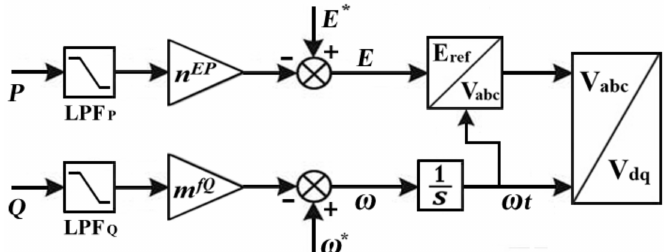
Figure 5. Block diagram of utilized droop